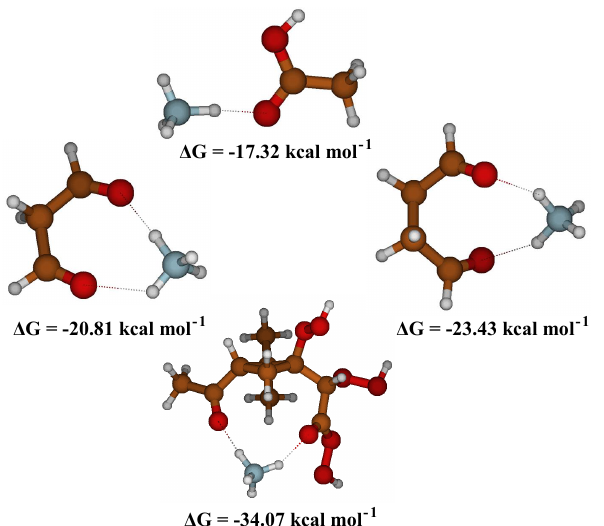
Figure 7. Quantum chemical calculations for different organic molecules with a carbonyl as the interacting functional group with NH + . Increasing the interacting groups from one to two increases 4 the stability of the cluster. The distance between the interacting groups also influences the cluster stability.